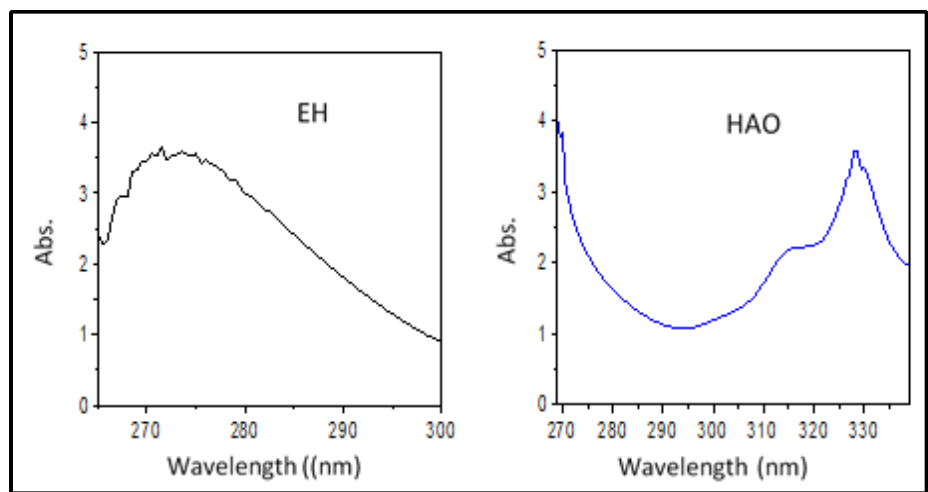
Figure 5. UV-visible spectra of EH and its HAO derivative in DMF.